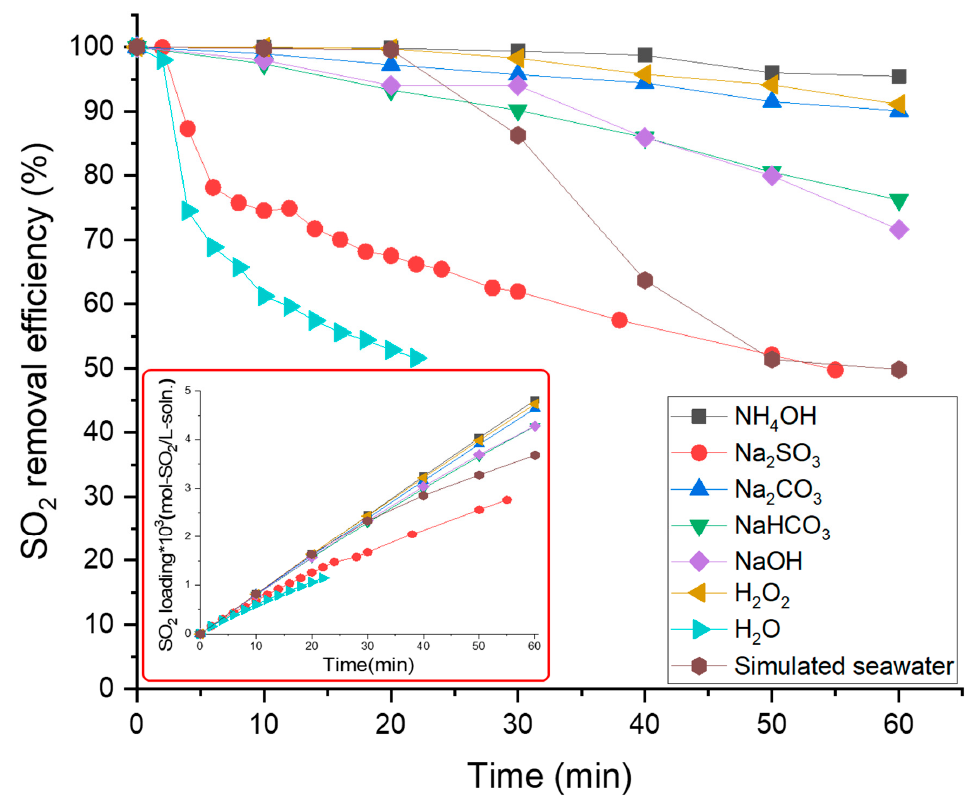
Figure 3. Effect of absorbents on SO 2 gas removal efficiency and SO 2 loading. When DI water was used as an absorbent, as reported in the results for general SO 2 removal experiments, the removal rate rapidly decreased from the beginning of the ex- periment, and then showed a removal rate of 50% or less in less than 30 min [16,32,33,46,47]. The tendency for various types of absorbents in this study is not much different from those in the previous studies. However, the simulated seawater showed somewhat high SO 2 removal efficiency for 30 min after the experiment. In the hollow fiber membrane contactor, the mass transfer between gas and liquid is achieved by diffusion through the hollow fiber membrane pores.